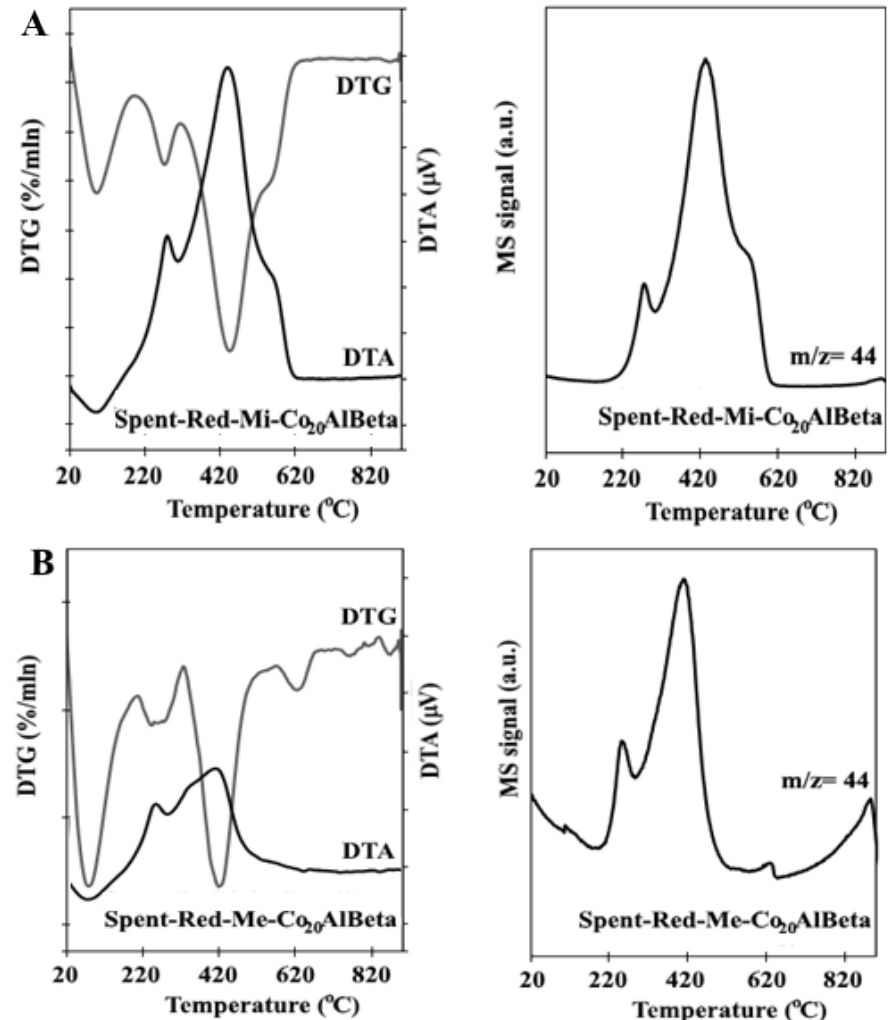
Figure 15. Investigation of carbon deposition on the ( A ) Spent-Red-Mi-Co 20 AlBeta and ( B ) Spent-Red-Me-Co 20 AlBeta.